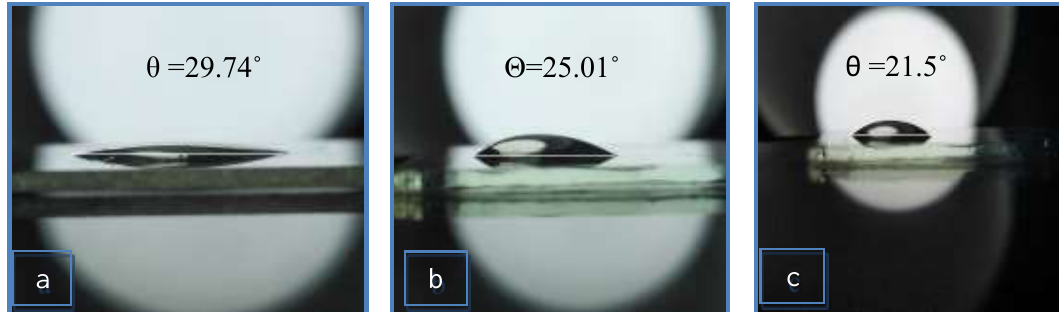
Fig.9b: Images of water droplet on the sample pure TiO2 (Tm3): a-15min Vis irradiation, b- after15 min. of Vis irradiation c- an hour Vis irradiation.